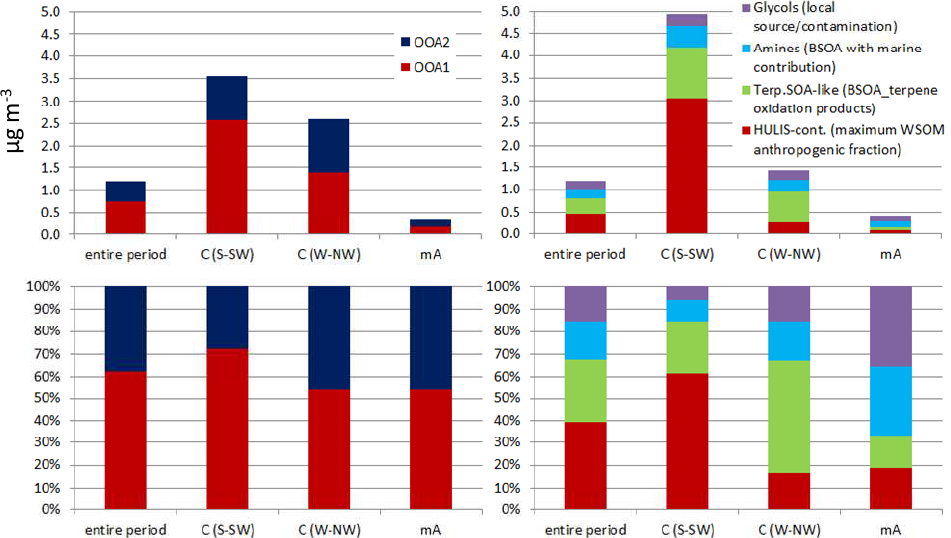
Fig. 12. Percentage and absolute concentrations (µgm − 3 ) of the Q-AMS OOAs and filters organic components averaged upon the entire sampling period and each distinct